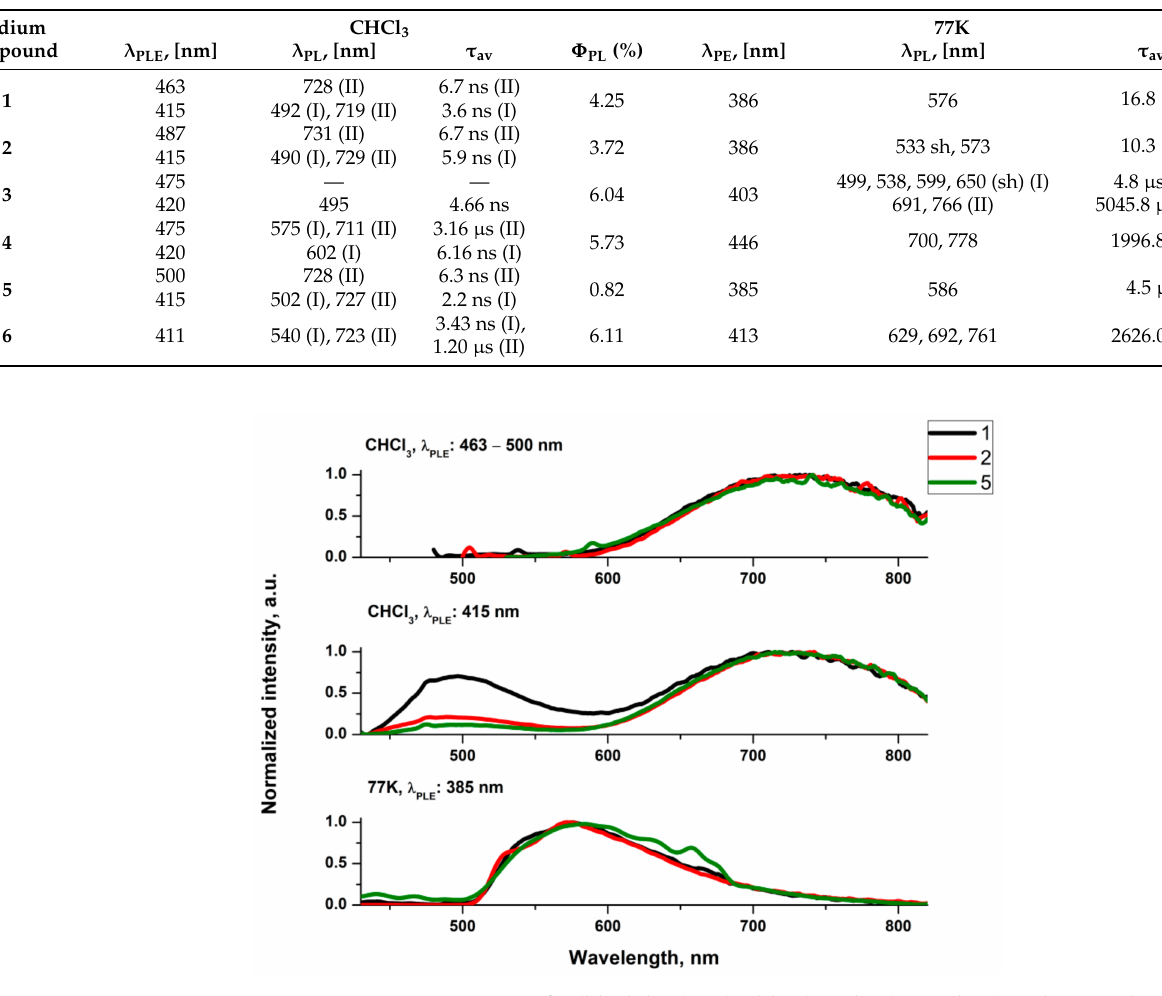
Figure 5. Emission spectra of 1 (black line), 2 (red line) and 5 (green line) in deaerated solutions CHCl 3 /CH 3 CN (concentration 25 µ M) and in the rigid matrix (MeOH:EtOH 1:4) at 77